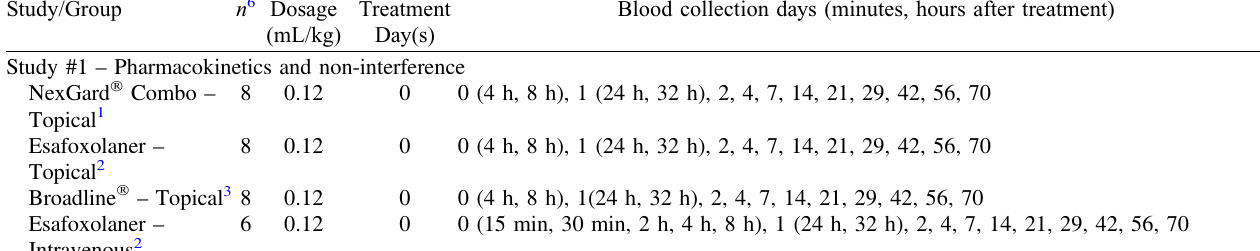
Study #2 – Dose proportionality and multiple-dose